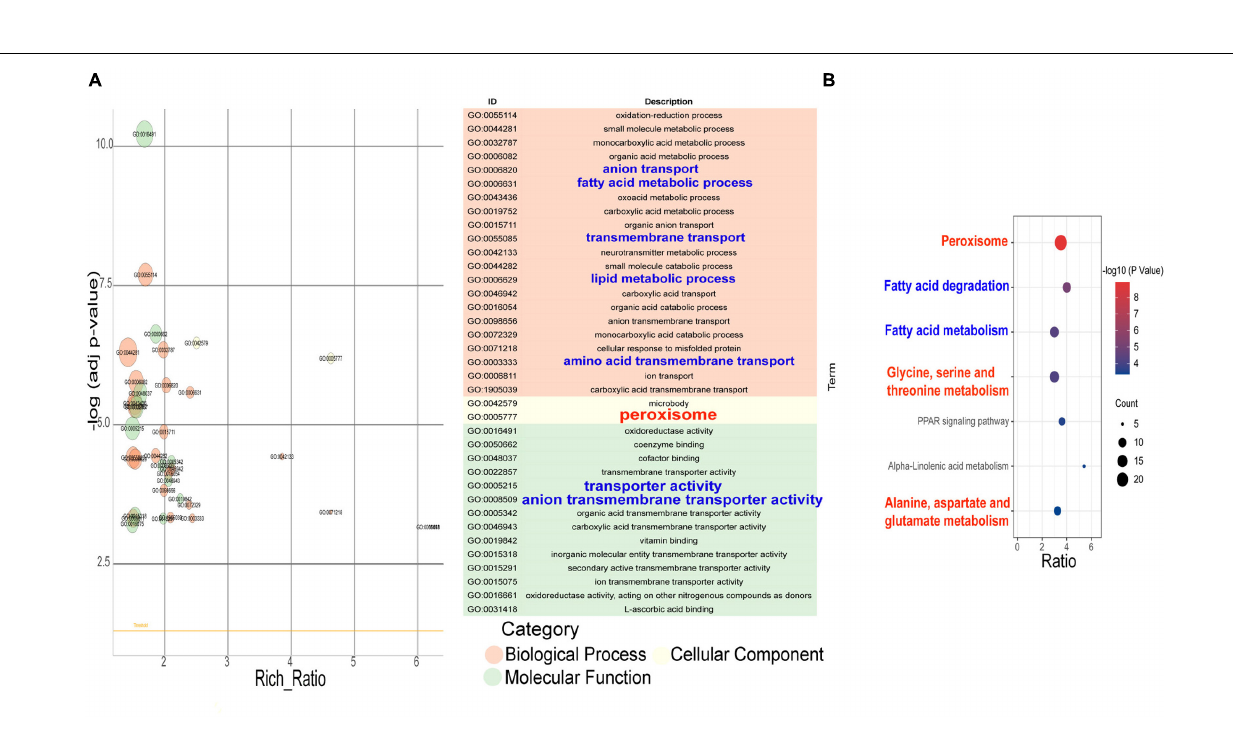
Frontiers in Microbiology |